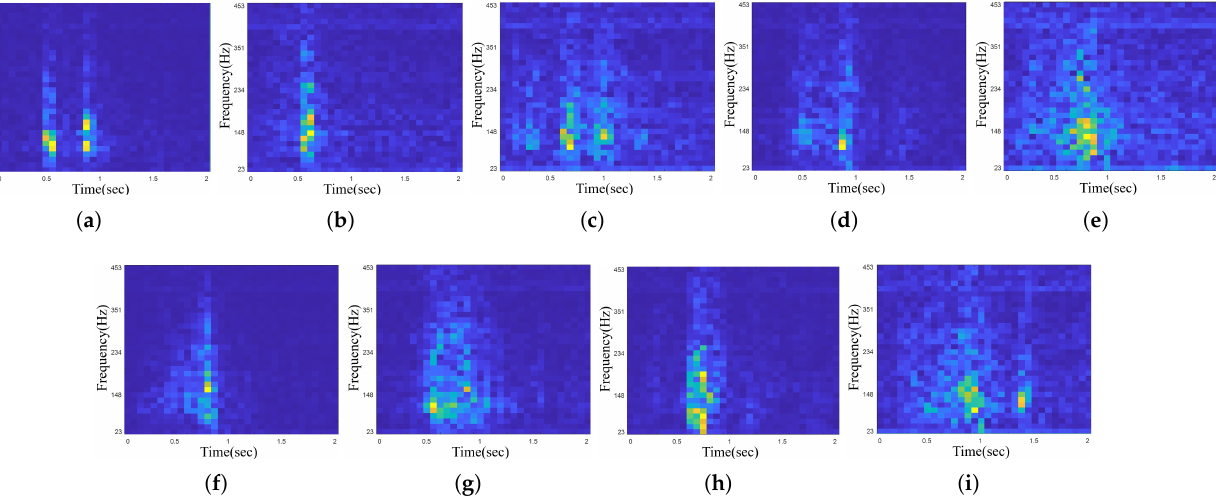
Figure 5. Spectrograms of nine gestures: ( a ) Gesture 1; ( b ) Gesture 2; ( c ) Gesture 3; ( d ) Gesture 4; ( e ) Gesture 5; ( f ) Gesture 6; ( g ) Gesture 7; ( h ) Gesture 8; ( i ) Gesture 9.